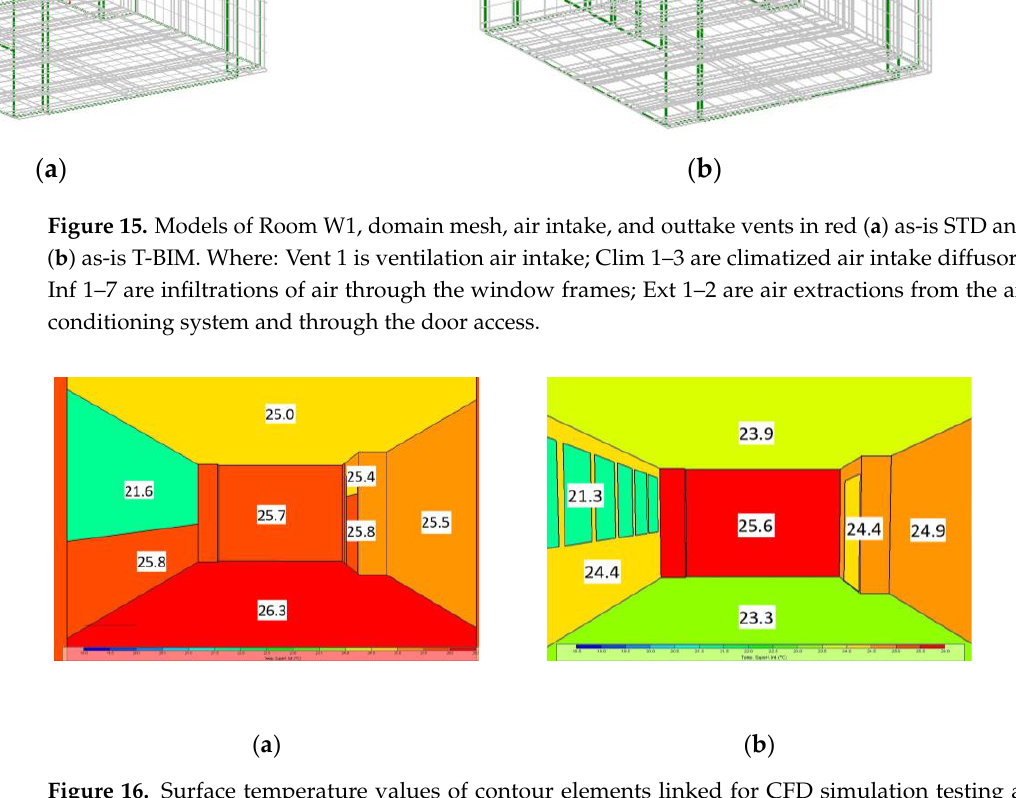
Figure 16. Surface temperature values of contour elements linked for CFD simulation testing at 17:00 h on 19 November, in Room W1: ( a ) as-is STD and ( b ) as-is T-BIM. Table 8. Intake and outtake air flows of contour elements linked for the CFD trial simulation at 17 h on 19 November, in Room W1.